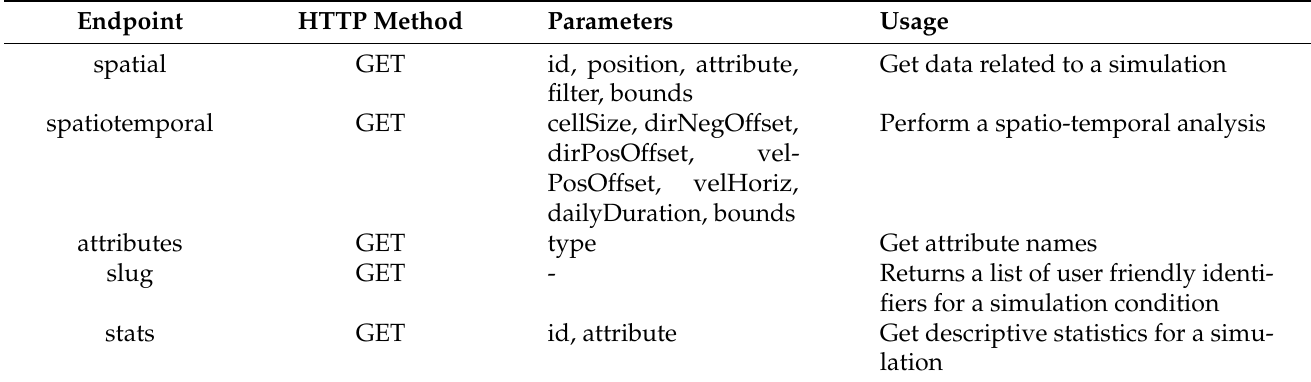
Figure 9. The public PostgreSQL database schema. In snake case are the column names and in capital the data types and additional directives. Table 2. The RESTful API endpoints and query parameters